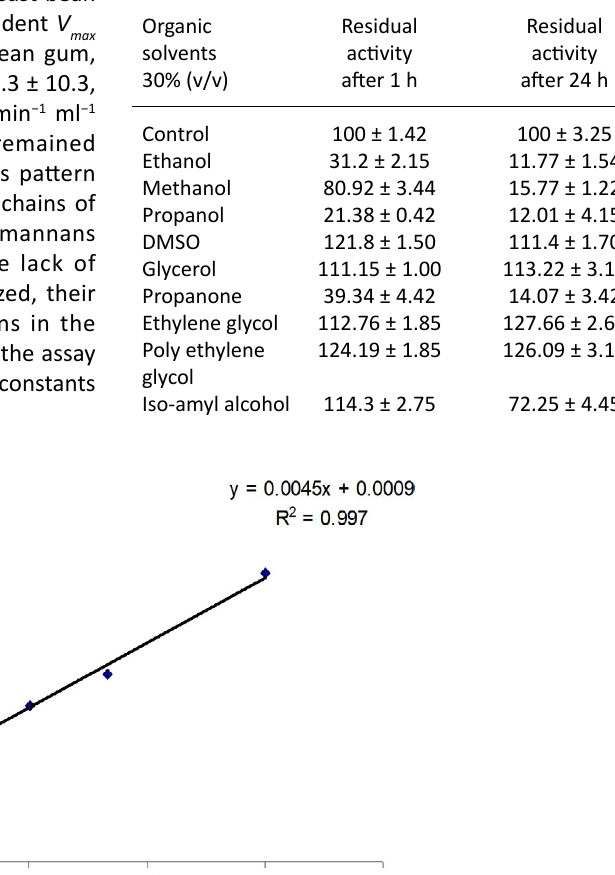
Table 3. Effect of stabilizers/ organic solvents on